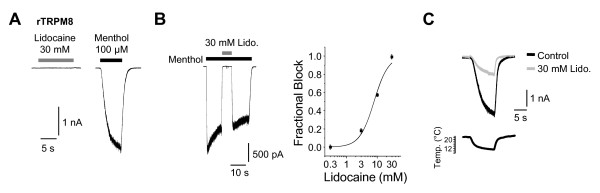
Lidocaine blocks but does not activate TRPM8. A. Typical recordings on rTRPM8 with a completely lacking response to 30 mM lidocaine but with a large inward current evoked by 100 μM menthol. Cells were held -60 mV B. Representative current trace displaying lidocaine-induced block of a menthol-evoked inward current on rTRPM8. Lidocaine was co-applied with menthol during the steady-state phase of menthol-evoked currents. The fractional block was plotted against the lidocaine concentration. The line represents the fit of the data to the Hill equation. C. Cold-induced inward currents of rTRPM8 in control solution (black) or in presence of 30 mM lidocaine (grey). The applied solution was cooled from room temperature (~ 24°C) to ~12°C within 10 seconds. Cells were held at -60 mV.